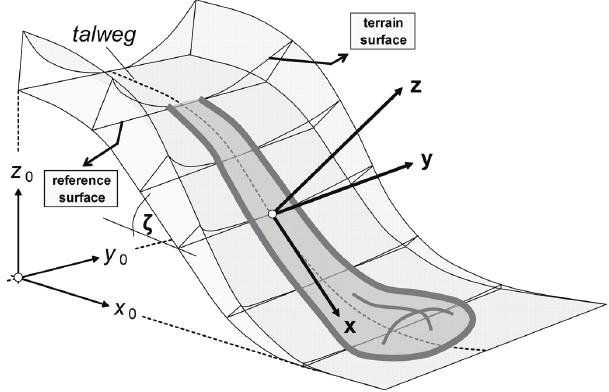
Fig. 1. Idealized topography for the solution of the extended Savage-Hutter Model by Wang et al. (2004), also used for r.avalanche